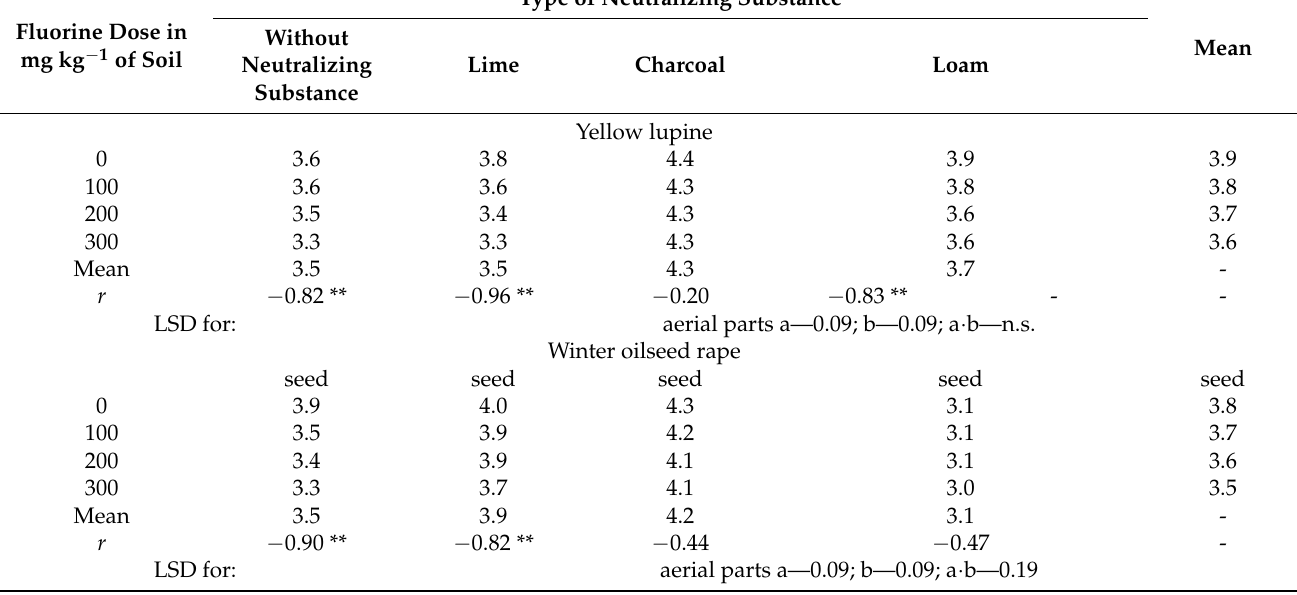
Table 4. Sulphur content in yellow lupine, winter oilseed rape, and narrow-leaf lupine aerial parts in g S kg − 1